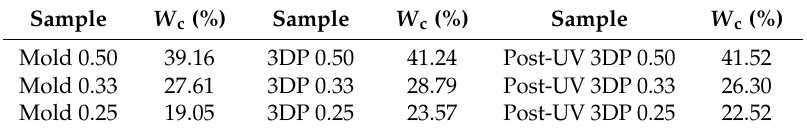
Figure 8. Wide-angle X-ray scattering (WAXS) patterns of thermal energy storage P(SA-DMAA) gels prepared with different methods and from different SA molar fractions. The high peak intensity represents the high crystallinity. Although no obvious influence of different methods on crystallinity was observed, the increasing amount of SA led to higher crystallinity. Table 1. The degree of crystallinity ( W c ) evaluated from WAXS patterns for P(SA-DMAA) gels.